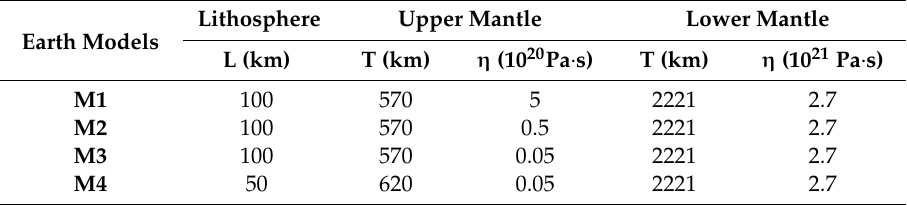
Table 1. Characteristics of the four Earth models (M1 to M4) used here to compute vertical displacements and changes in the geoid height induced by the drying-up of the MLC. Notation: L corresponds to lithosphere thickness, T and η correspond to mantle thickness and viscosity, respectively. The core-mantle and upper-lower mantle boundaries are at depths of 2891 km and 670 km,